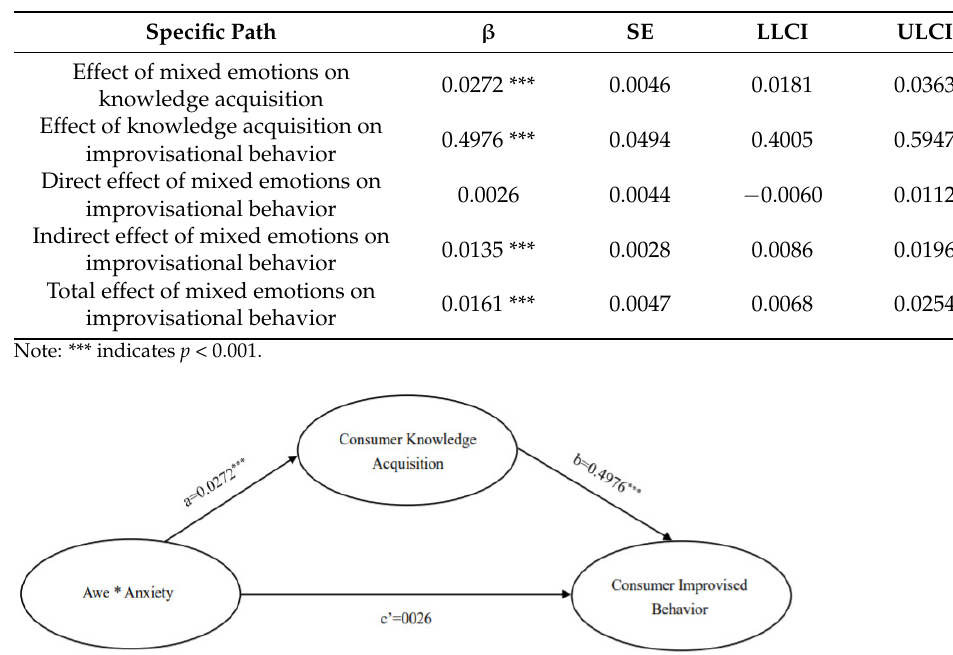
Figure 3. Mediating effect analysis. Note: Awe * Anxiety represents the interaction of the two variables of awe and anxiety; *** indicates p < 0.001.